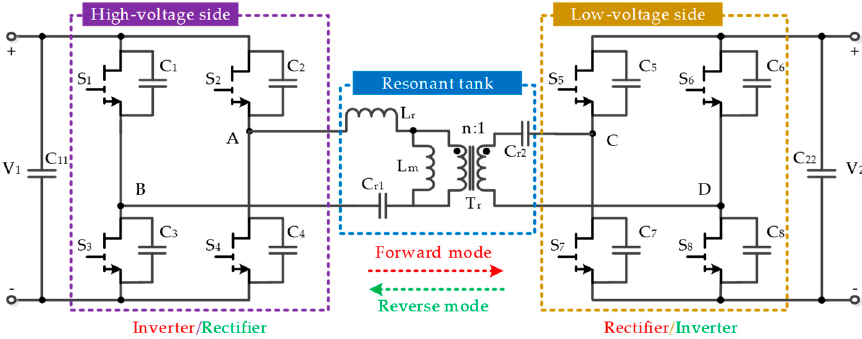
Figure 3. Structure of GaN-based CLLC-BRC.